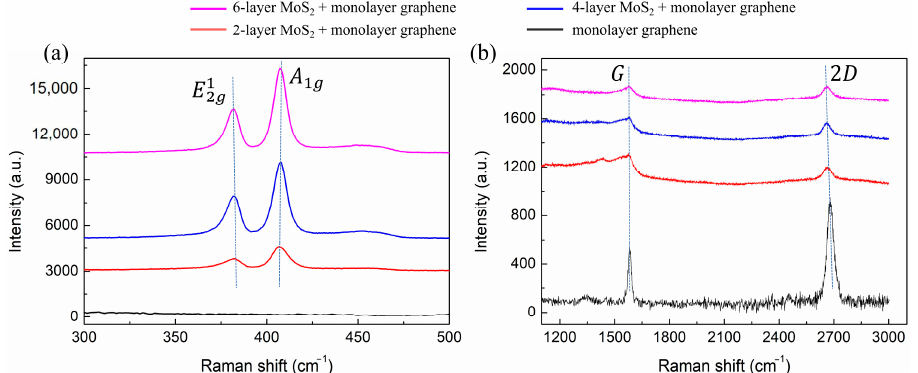
Figure 8. Raman spectra of monolayer graphene on SiO 2 substrate and the fabricated graphene–MoS 2 hybrid-structure sensor with different layers of MoS 2 for ( a ) 300~500 cm − 1 ; ( b ) 1100~3100 cm − 1 .